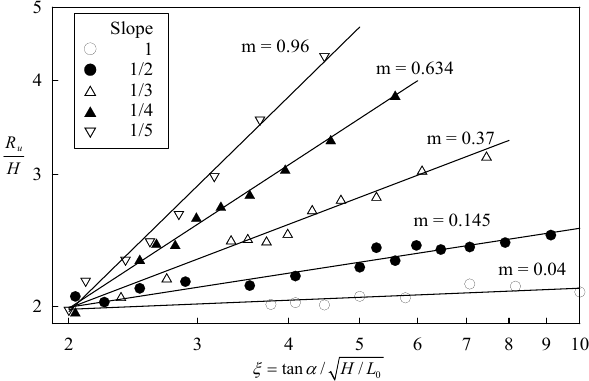
Fig. 5. Numerical results of R u /H versus ξ in logarithmic coordi- Figure 5. Numerical results of / nate for different structure structure slopes. 3